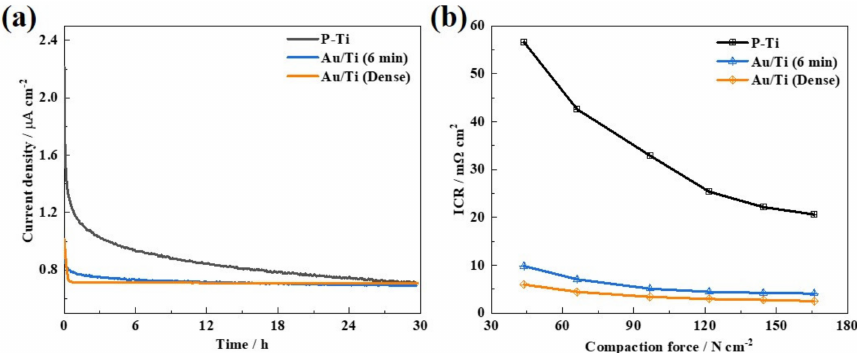
Figure 7. ( a ) Chronoamperrometry curves of the Au/Ti (6 min), ( b ) ICR at 140 N cm − 2 after the LTST of the P-Ti, Au/Ti (6 min) and Au/Ti